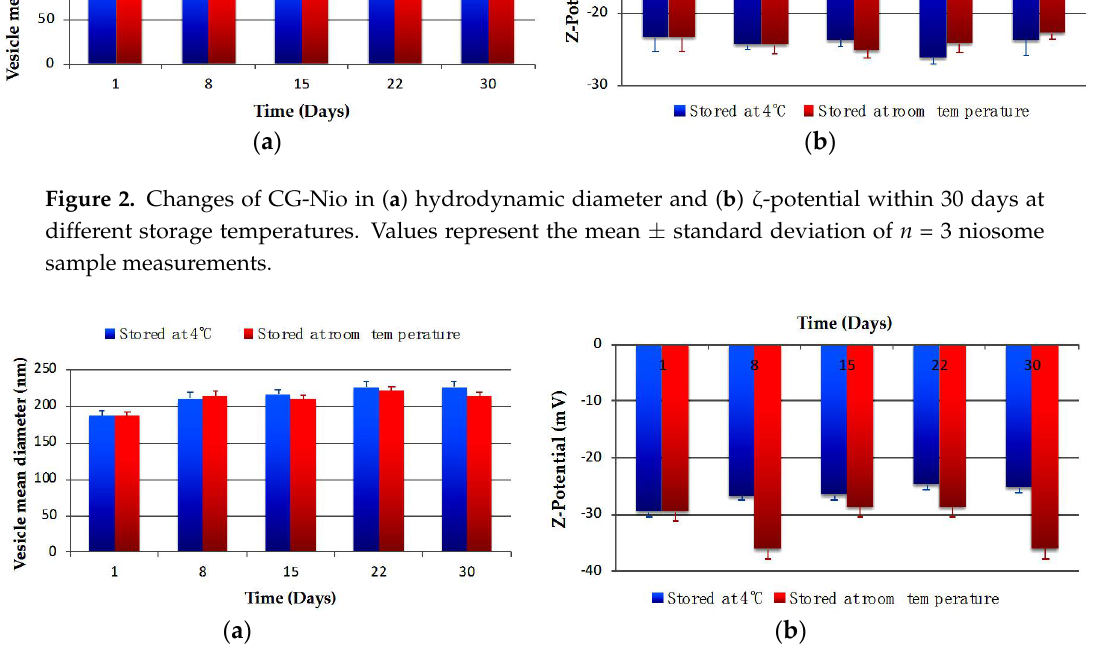
Figure 3. Changes of CG-NioP in ( a ) hydrodynamic diameter and ( b ) ζ-potential within 30 days at different storage temperatures. Values represent the mean ± standard deviation of n = 3 niosome sample measurements.